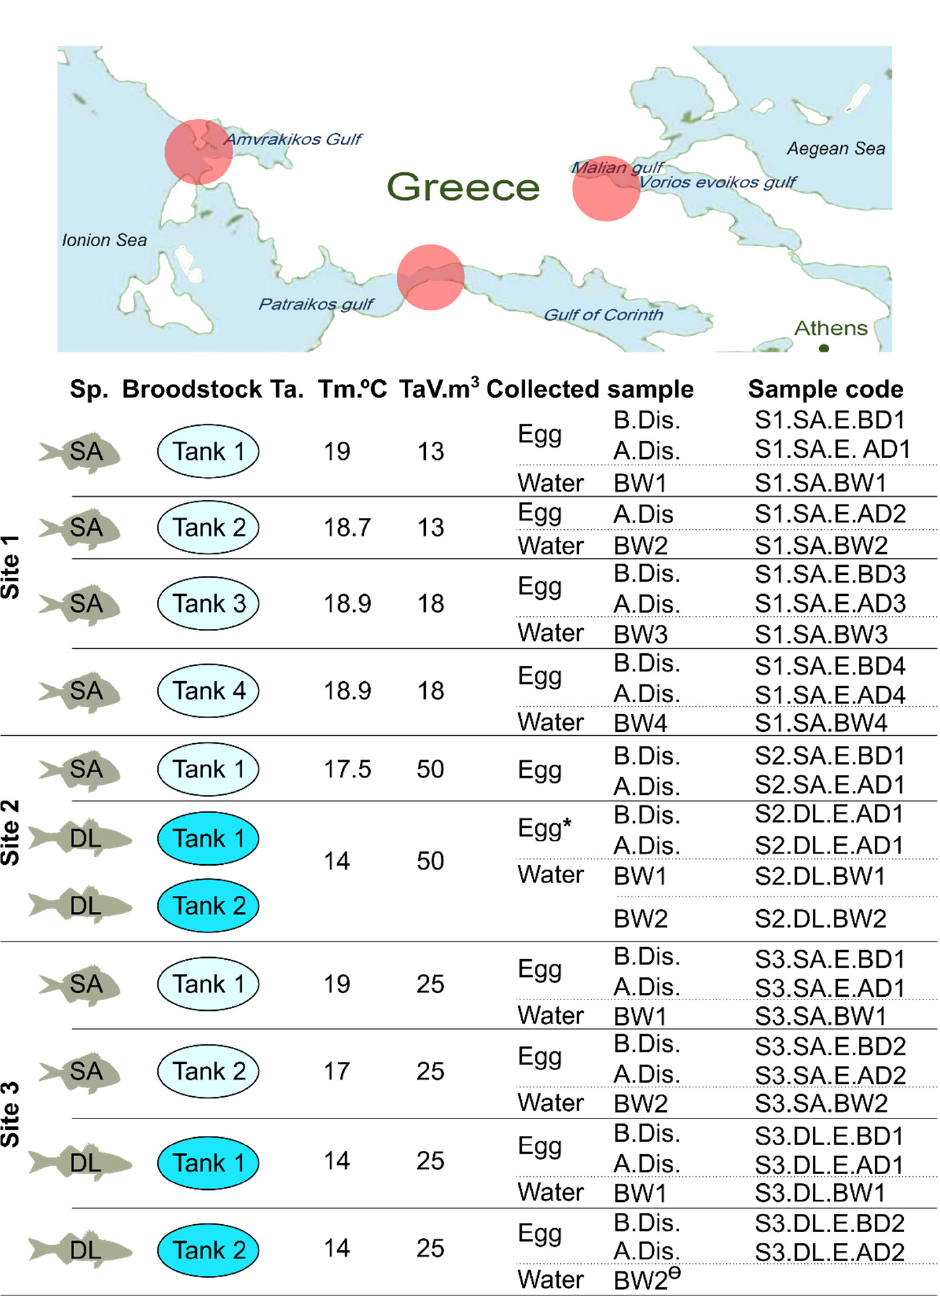
Figure 1. A schematic representation of the approximate location of the hatcheries and the experi- mental design. Egg and water samples were collected from the three different sites/hatcheries (red circles on the map) and different broodstock in January 2020. Egg samples of the gilthead seabream (SA) and the European seabass (DL) were taken before (B.Dis.) and after (A.Dis.) standard egg disinfection procedures at each site. For easy tracking of samples and their results, sample codes were assigned to each of the collected samples (see last column). Sp. (species); BW (broodstock water); Ta. (tank); Tm. (temperature in ◦ C); TaV. (tank volume in m 3 ). Note: * the eggs from two broodstock were mixed in this case. Ө— sequencing of this specific water sample did not proceed because insufficient DNA was obtained during